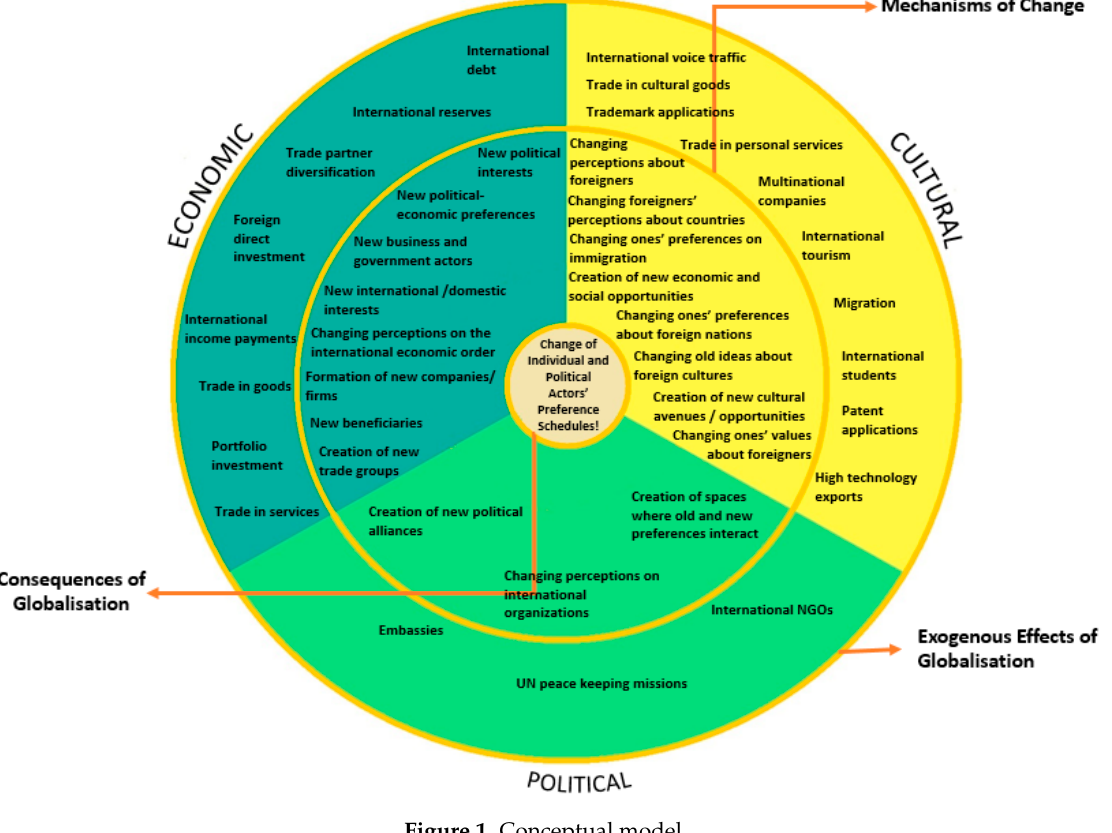
Figure 1. Conceptual model.